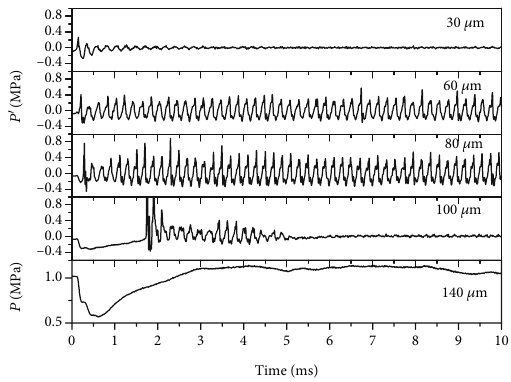
Figure 5: The time histories of pressure oscillations in Case 1-Case